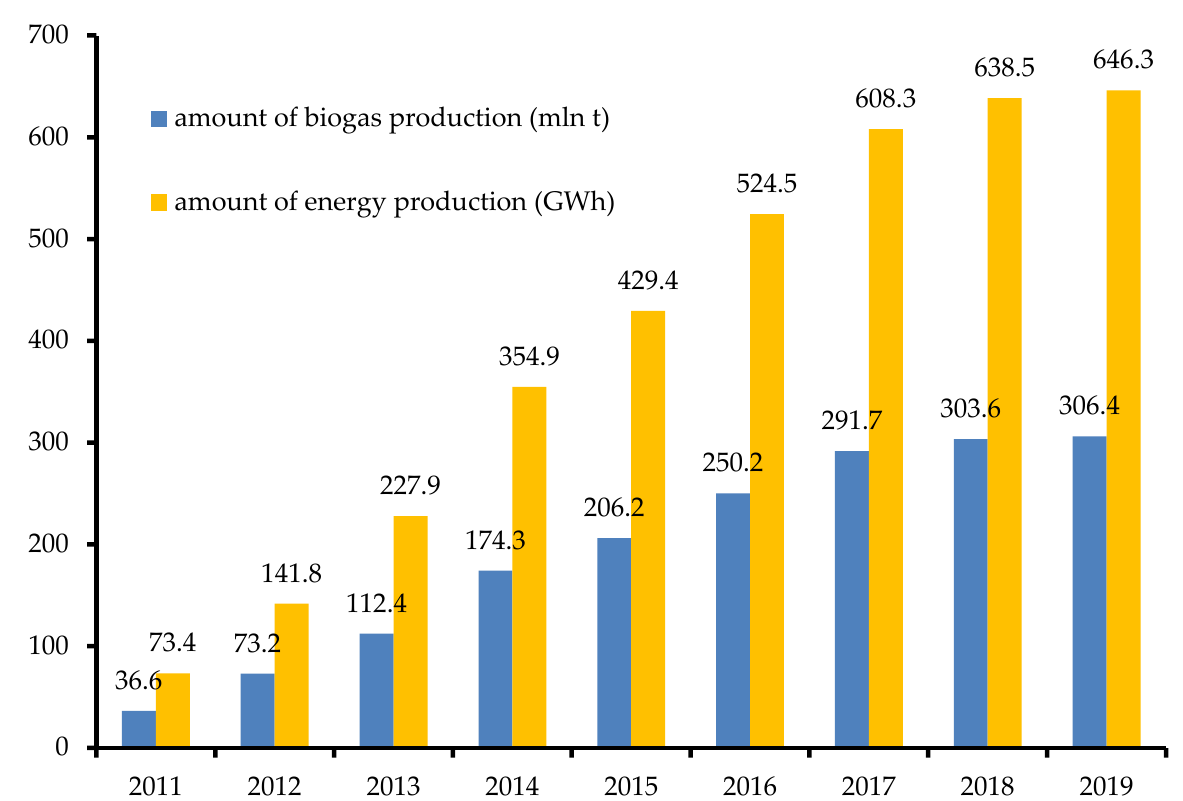
Figure 2. Production of agricultural biogas and electrical energy in agricultural biogas plants in Poland. Source: based on Agricultural Market Agency/National Agricultural Support Center data.